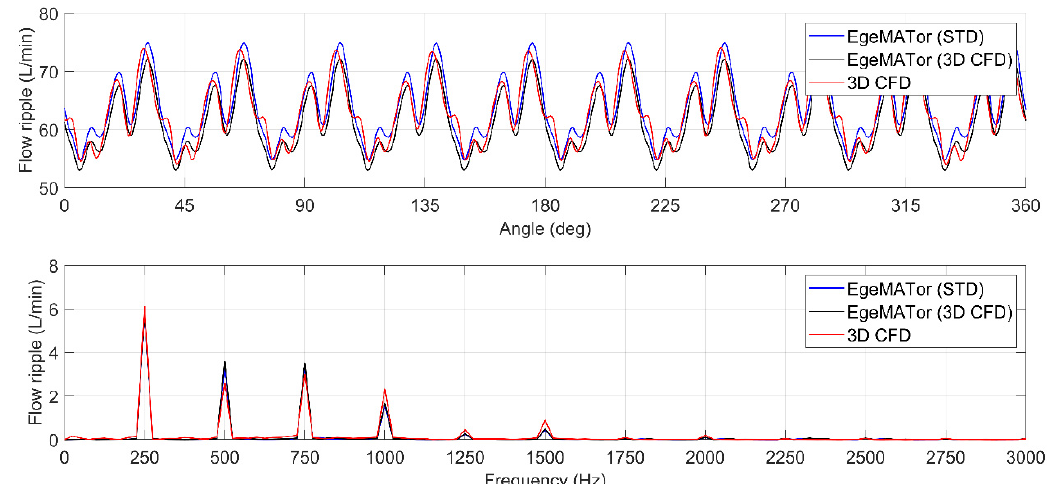
Figure A1. Flow ripple comparison at 1500 rpm and 260 bar for a 10-teeth EGP in time and frequency domains.